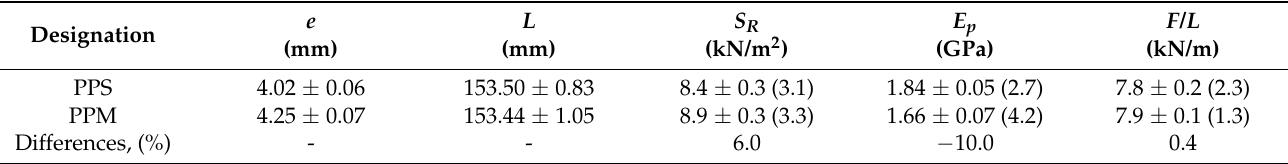
Figure 5. Ring stiffness and flexibility characteristics.